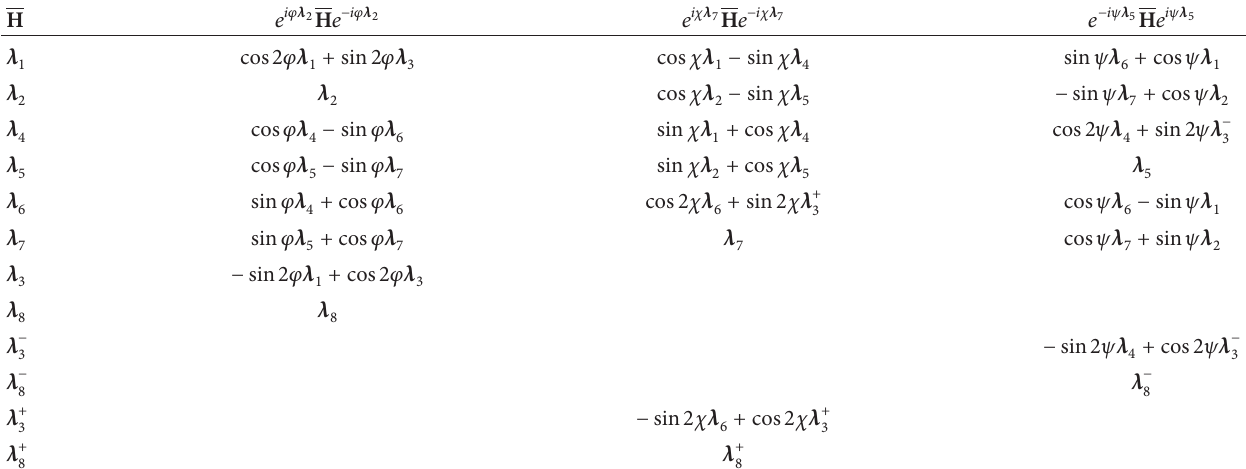
Table 8: Similarity transforms of Gell-Mann matrices through elementary